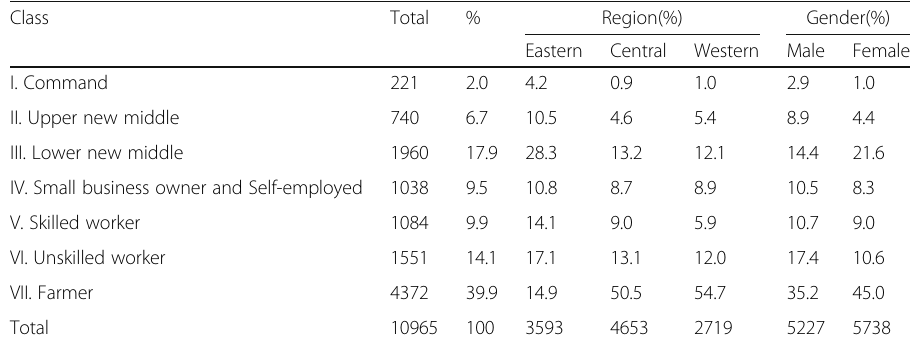
Table 6 Class structure in transitional China: 2010 CGSS Class